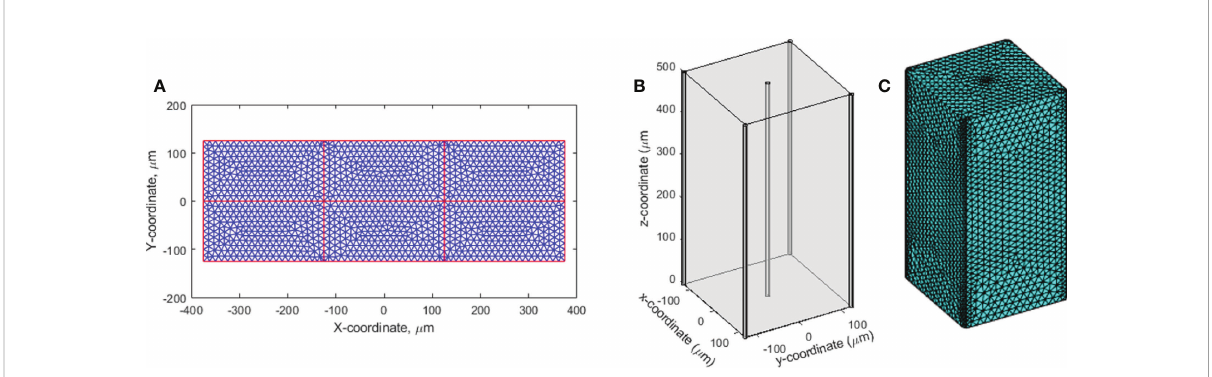
FIGURE 1 2D and 3D geometries for oxygen distribution solution to Eq (1). (A) The 2D region to simulate the dynamic oxygen level changes under various dose rates. The vessels across the region are shown in red color. The triangular mesh is illustrated and shown in 10 times of its actual size. (B) The 3D cuboid geometry. Five vessels across the region at the center and four vertical edges concurrently provide oxygen supplies. (C) The 3D